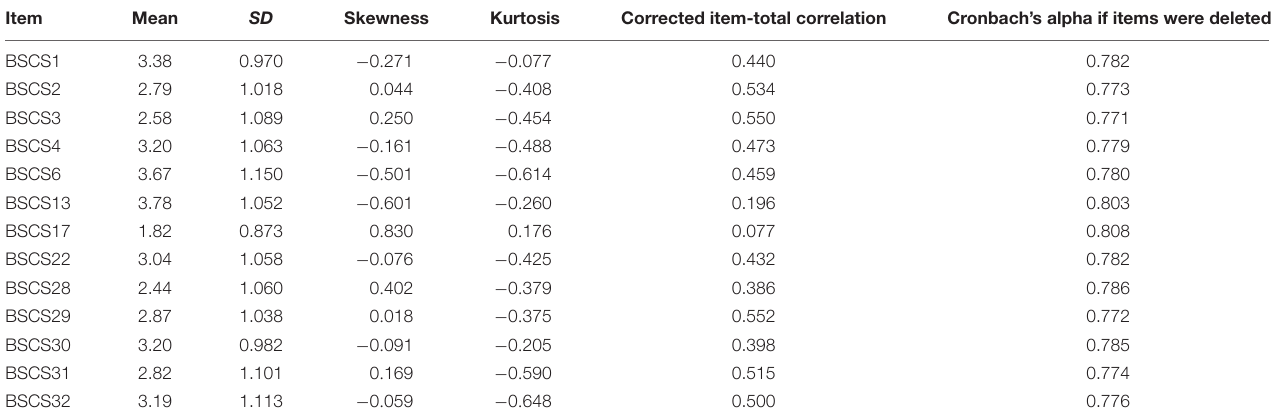
TABLE 1 | Descriptive statistics for 13-item BSCS scale.